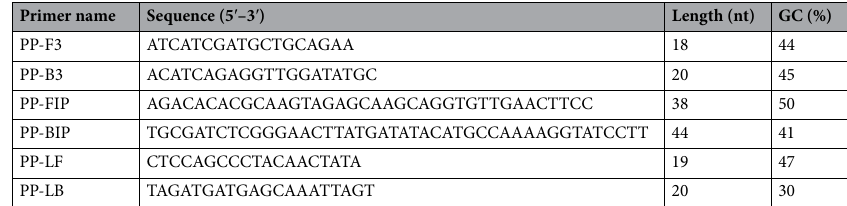
Table 1. Primers designed using petF1 gene region to develop loop-mediated isothermal amplification assay for specific and rapid detection of Pectobacterium parmentieri